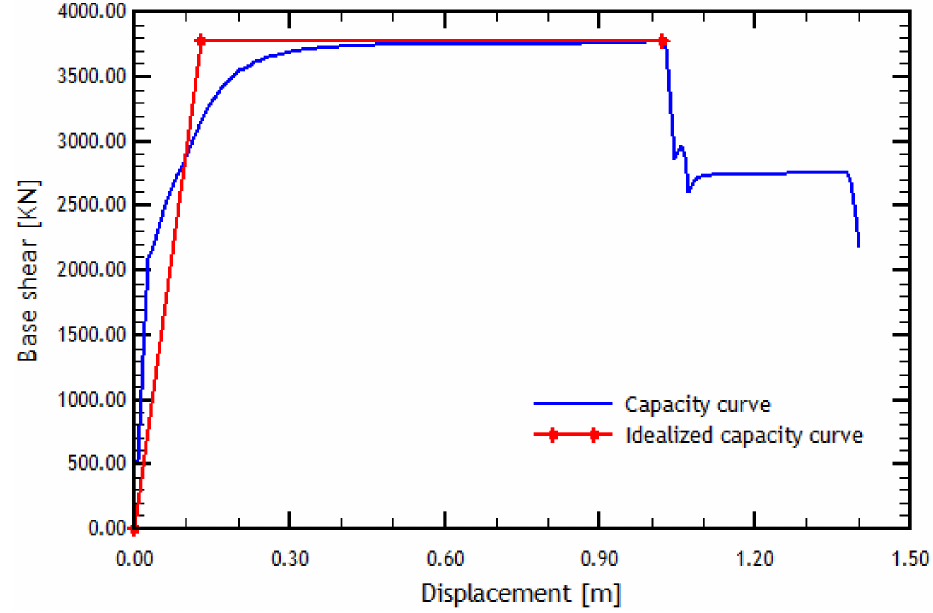
Figure 4. Analytical and idealized capacity curves in the longitudinal